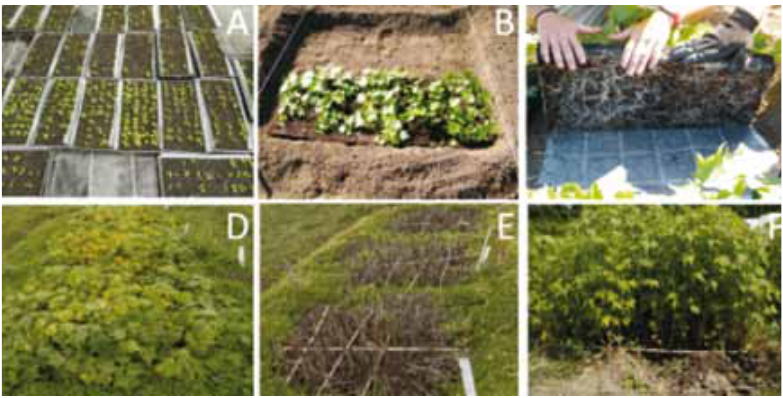
Figure 2. Process of the nurse ­in­tray plantlet production of Sida hermaphrodita Rusby. A: 1 week after sowing (05/08/2013) in different densities. B: 1.5 m x 1.2 m experimental planting trenches (29/08/2013). C: soil mixture interwoven with the four ­ week­old plantlets, removed from the nurse­in­tray (30/08/2013). D: four ­ month­old population (10/12/2013). E: Seven­ month ­old population, before shooting (10/03/2014); F: Ten­month.old plants